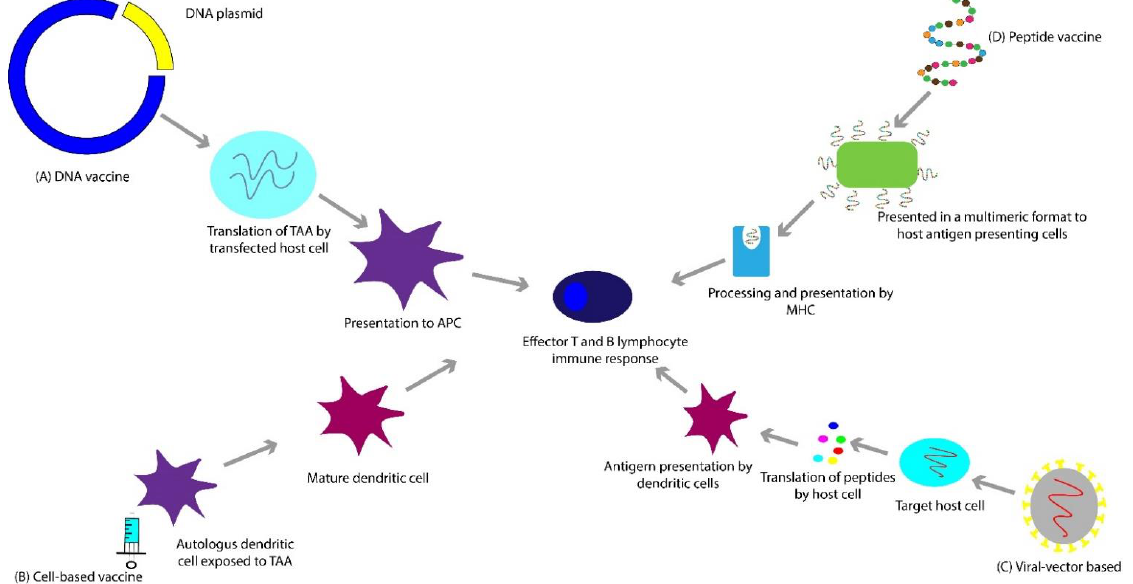
Figure 1. ( A ) DNA vaccines employ a plasmid, which gets translated to a tumor-associated antigen. ( B ) Cell-based vaccines utilize whole cells as a source of antigen. ( C ) Viral-vector based vaccines are based on the process of transfecting the host cell with a viral vector, that contains a gene which encodes a tumor-associated antigen. ( D ) Peptide-based vaccines consist of subunits of an epitope of a tumor-associated antigen, sometimes presented in a multimeric format (e.g., virus-like particles (VLPs)) to elicit an effective immune